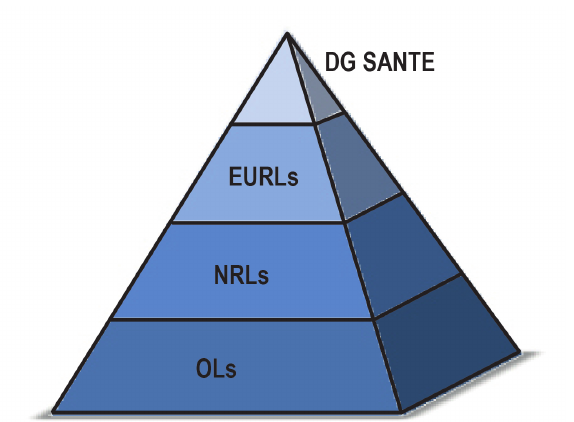
Figure 1. European Union food control network: The Directorate General SANTE (DG SANTE) is the Commission department responsible for EU policy on food safety and health and for mon- itoring the implementation of related rules; the network of laboratories is constituted of the EU Reference Laboratories (EURLs), the EU National Reference Laboratories (NRLs) and the official laboratories